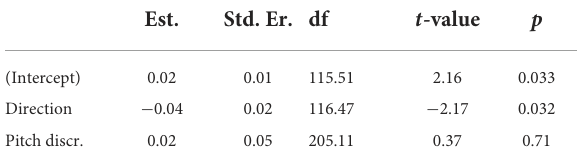
TABLE 1 Regression analysis of f 0 -motion mapping congruency (Main experiment).